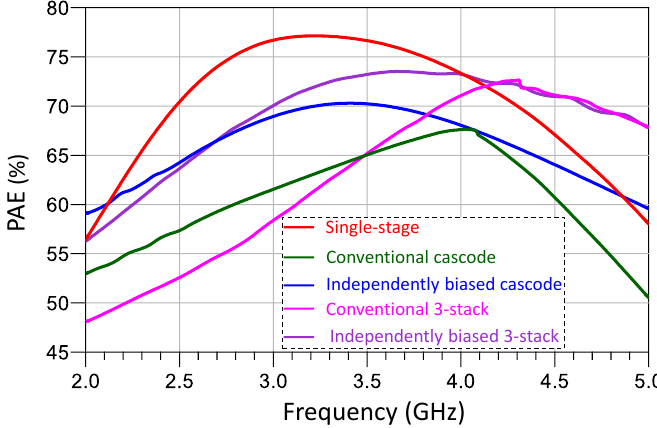
Figure 16. Power added efficiency (PAE) bandwidth comparison among